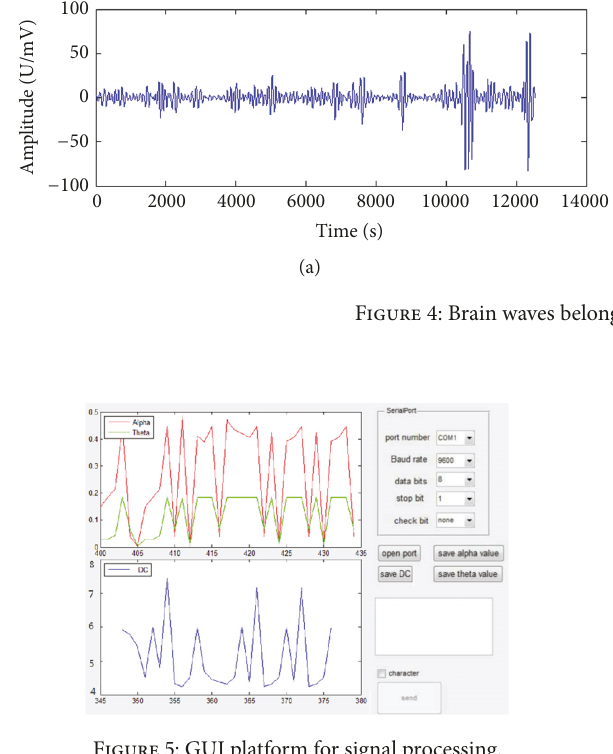
Figure 5: GUI platform for signal processing.